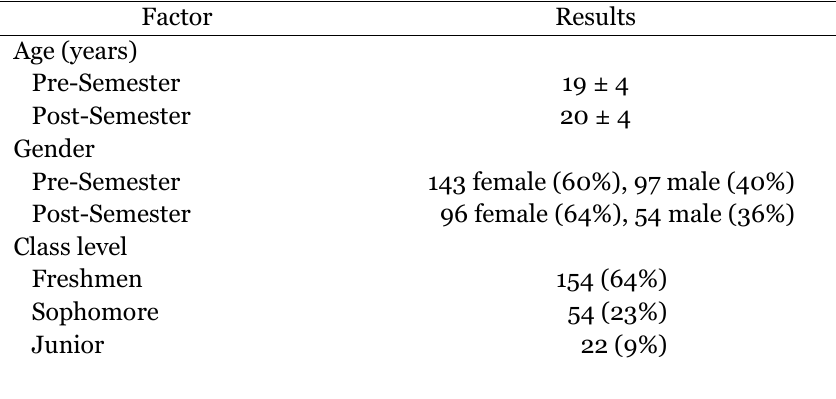
Participants’ Demographic and Academic History